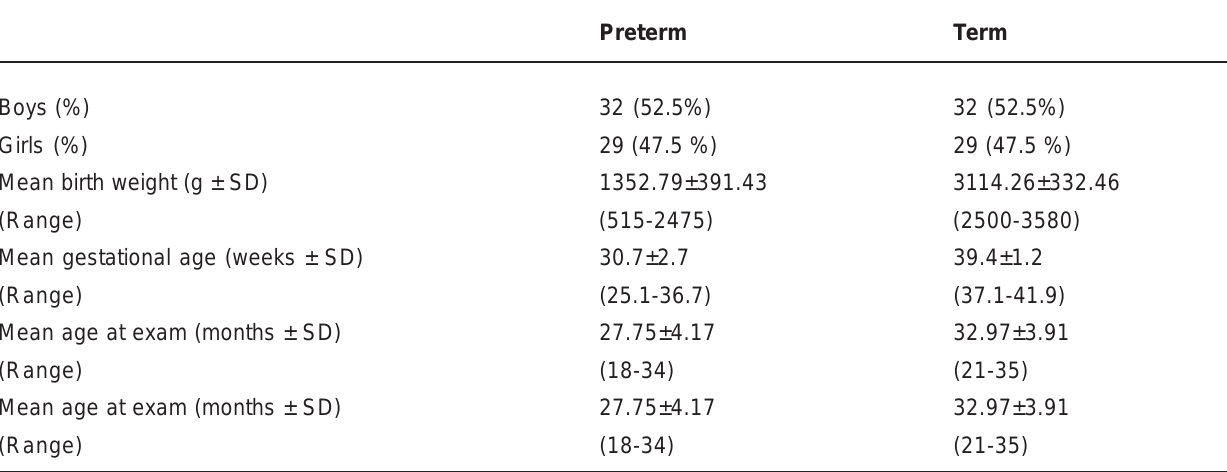
TABLE 1- Demographic data of the subjects enrolled in the study